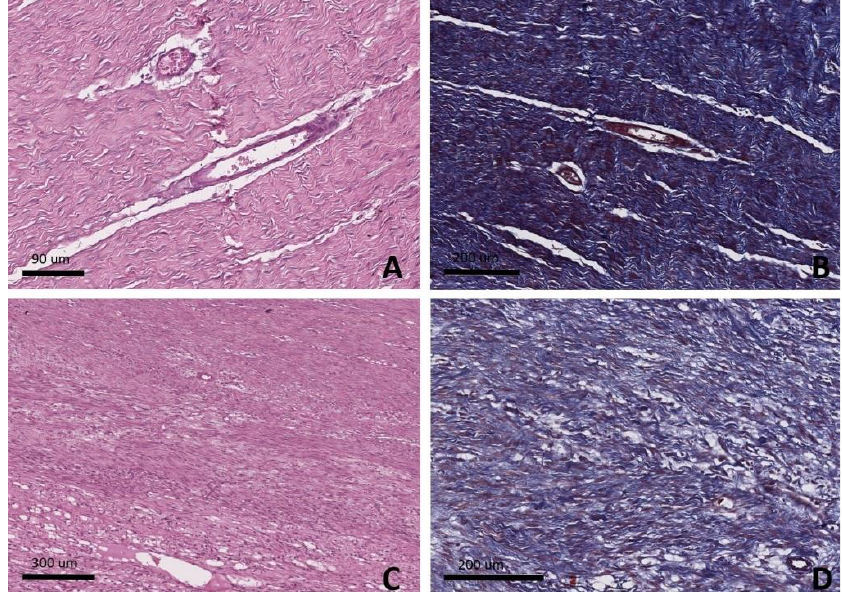
Figure 6. Histopathology. ( A ) H&E staining of ADMSC group. Vascular neoformation is observed along with moderately disorganized fibers and formation of blood vessels with cellular aggregates. ( B ) Masson’s trichrome of ADMSC group. Vascular neoformation is observed along with moderately disorganized fibers. ( C ) H&E staining of lesion group. Areas of inflammatory infiltrate are observed along with abundant areas of adipose infiltration between the collagen fibers, few blood vessels, and necrotic foci. ( D ) Masson’s trichrome of lesion group. Areas of inflammatory infiltrate are observed along with abundant areas of adipose infiltration between the collagen fibers, few blood vessels, and necrotic foci. Table 5. Histopathology results with GHBCS.